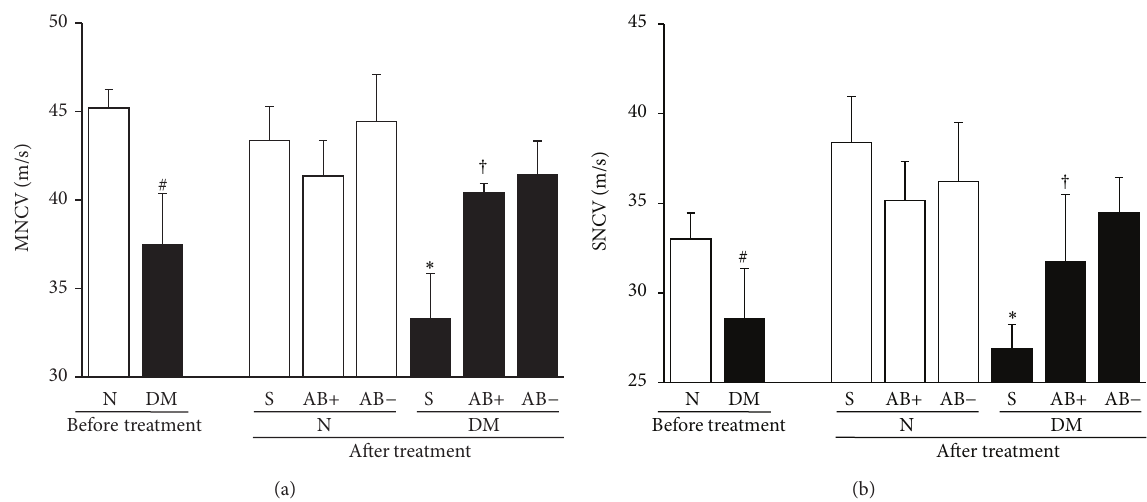
Figure 9: Transplantation of angioblast-like cells induced from ES cells (ES-ABs) improved delayed nerve conduction velocities (NCVs) in diabetic mice. Motor nerve conduction velocity (MNCV) (a) and sensory nerve conduction velocity (SNCV) (b) of diabetic mice were significantly delayed compared with those of normal mice after 12 weeks duration of diabetes. The delays in MNCV and SNCV were significantly restored by ES-ABs transplantation. However, administrations of ES-ABs did not alter NCVs in normal mice. N: normal mice limbs, DM: diabetic mice limbs, S: saline-injected limbs, AB+: limbs transplanted ES-ABs, and AB − : contralateral limbs transplanted ES-ABs. Results are means ± SD. # 𝑃 < 0.05 versus pretreatment N, ∗ 𝑃 < 0.05 versus posttreatment S-treated N, and † 𝑃 < 0.05 versus posttreatment S-treated DM. 𝑛 = 6 in each pretreatment group and 𝑛 = 7 –10 in each posttreatment